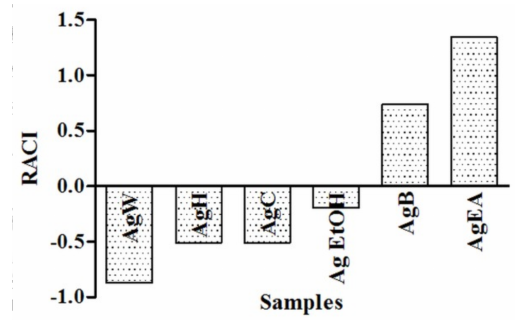
Figure 1. Relative Antioxidant Capacity Index (RACI) of Azorella glabra samples. Samples are crude ethanol extract (Ag EtOH), n -hexane fraction (AgH), chloroform fraction (AgC), ethyl acetate fraction (AgEA), n -butanol fraction (AgB), and water fraction (AgW).